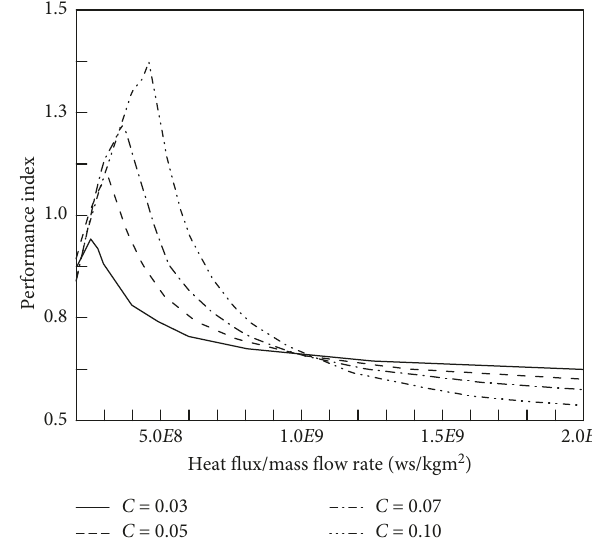
Figure 6: Effect of heat flux per unit mass flow rate on the per- formance index for various concentrations of S44 PCM slurry.